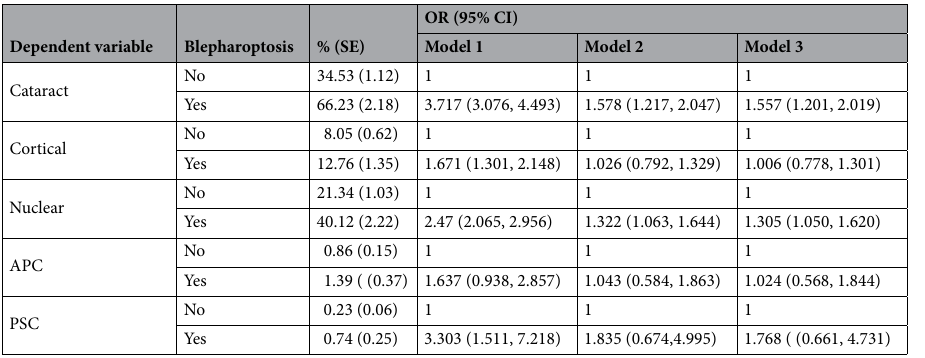
Table 3. ORs (95% CI) of the different subtypes of cataract for the subjects with blepharoptosis. Model 1: unadjusted, Model 2: adjusted for sex and age, Model 3: adjusted for sex, age, smoking, drink, regular exercise, BMI, income, education level, vitamin D, and sun exposure. APC anterior polar cataract, PSC posterior subcapsular opacity.